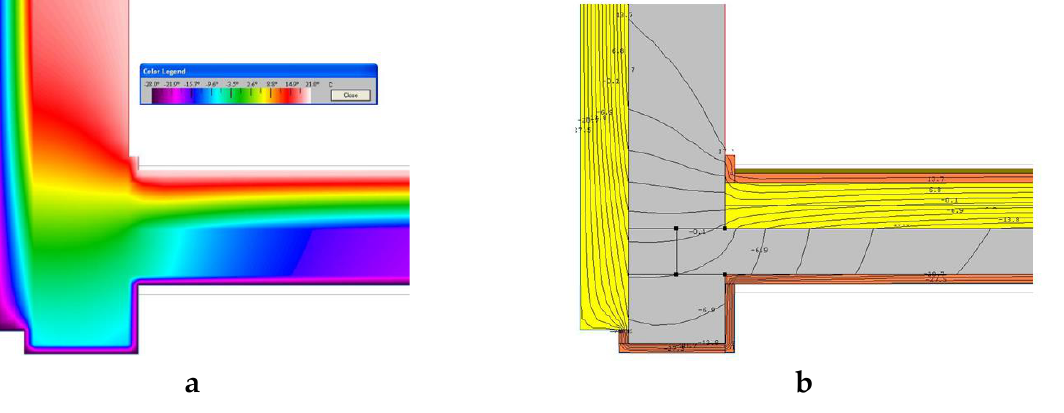
Figure 9. Structure of the temperature field formation in an isolated structure: ( a ) — visualization of the temperature field; ( b ) — graphical interpretation of the temperature distribution.